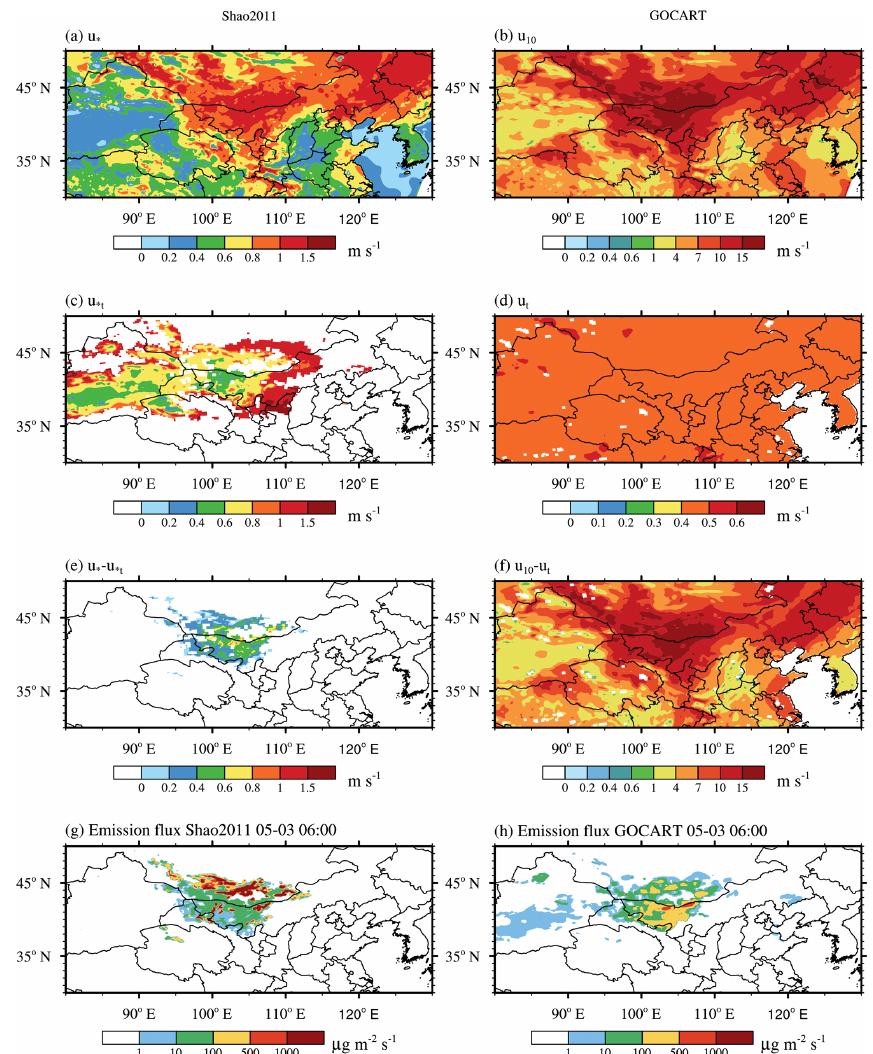
Figure 5. Spatial distributions of (a) friction velocity ( u ∗ ) , (c) threshold friction velocity ( u ∗ t ) , and (e) the difference between u ∗ and u ∗ t ( u ∗ − u ∗ t ) from Shao2011 dust emission scheme at 06:00UTC on 3 May 2017; (b) wind speed at 10m ( u 10 ) , (d) threshold velocity ( u t ) , and the difference between u 10 and u t ( u 10 − u t ) from the GOCART dust emission scheme at 06:00UTC on 3 May 2017. Spatial distribution of (g) dust emission flux from Shao2011 and (h) dust emission flux from GOCART at 06:00UTC on 3 May